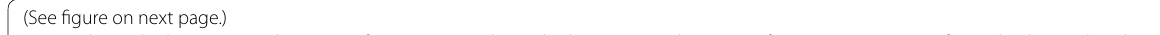
(See figure on next page.) Fig. 2 The multiple sequence alignment of SGR proteins. The multiple sequence alignment of SGR proteins was performed utilizing Clustal W 2.0.3 (http://www.ebi.ac.uk/clust alw/). The green, black, and red lines denote the chloroplast transit peptide, SGR domain, and variable C-terminal region. The information of the SGR proteins is in Additional file 1: Table